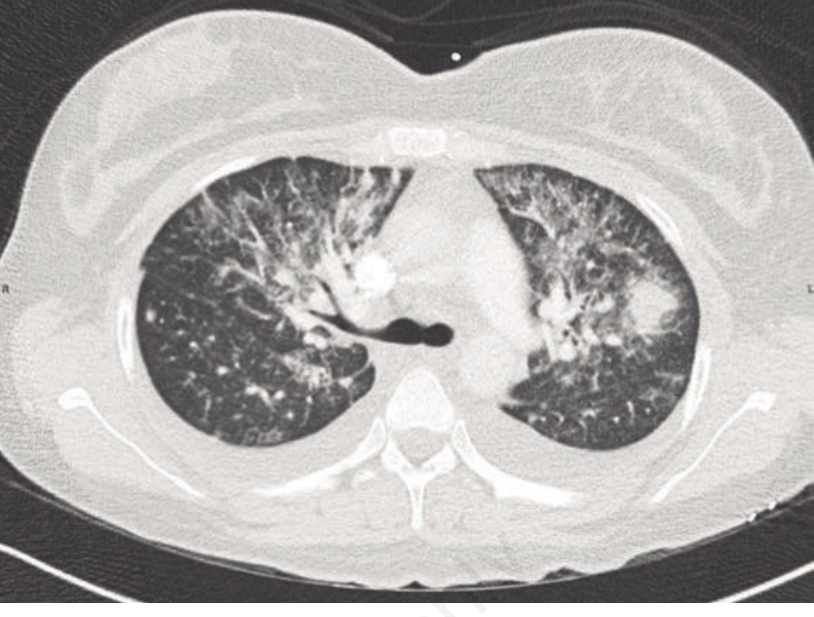
Figure 1. Computed axial tomography of the chest performed with intravenous contrast showing bilateral nodular opacifications in a bronchovascular distribution.